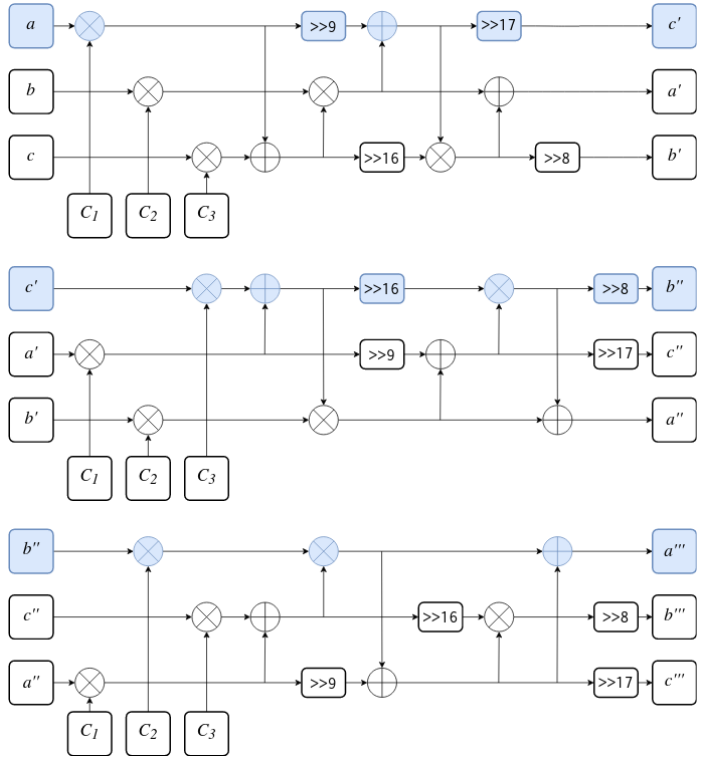
Figure 7. The f function made of three iterations of f ot